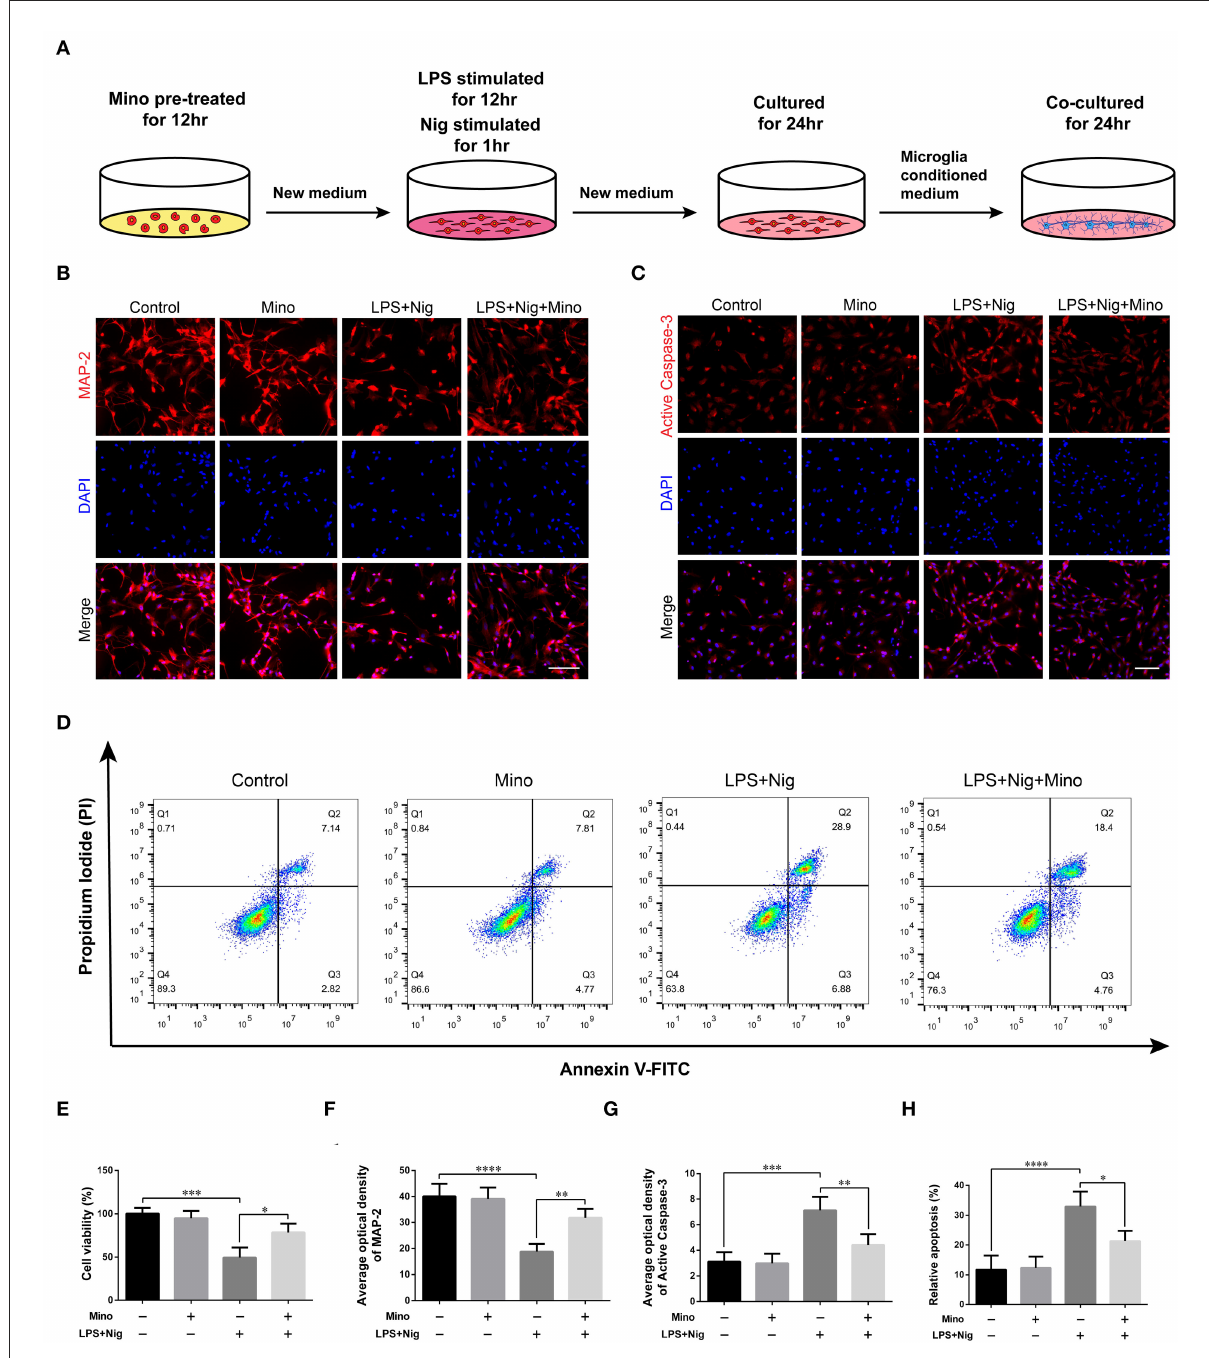
FIGURE6 Dampening NLRP3-associated inflammatory environment alleviated the damage in primary cortical neurons cultured in microglia-conditioned medium. (A) Experimental protocols related to primary neurons. (B,C) Representative images of MAP2 and cleaved caspase-3 immunofluorescence in primary neurons cultured in microglia-conditioned medium of each group. Scale bars = 100 µ m. (D) Representative images of cell apoptosis in primary neurons of each group as determined by flow cytometry. (E) The viability of primary neurons was measured using a CCK assay. (F–H) Quantitative analyses of the average optical densities of MAP2 and cleaved caspase-3, and apoptosis of each group (data are presented as means ± SD, n = 3 for the CCK assay, n = 4 for the immunofluorescence and flow cytometric assays; * p < 0.05, ** p < 0.01, *** p < 0.001, **** p <